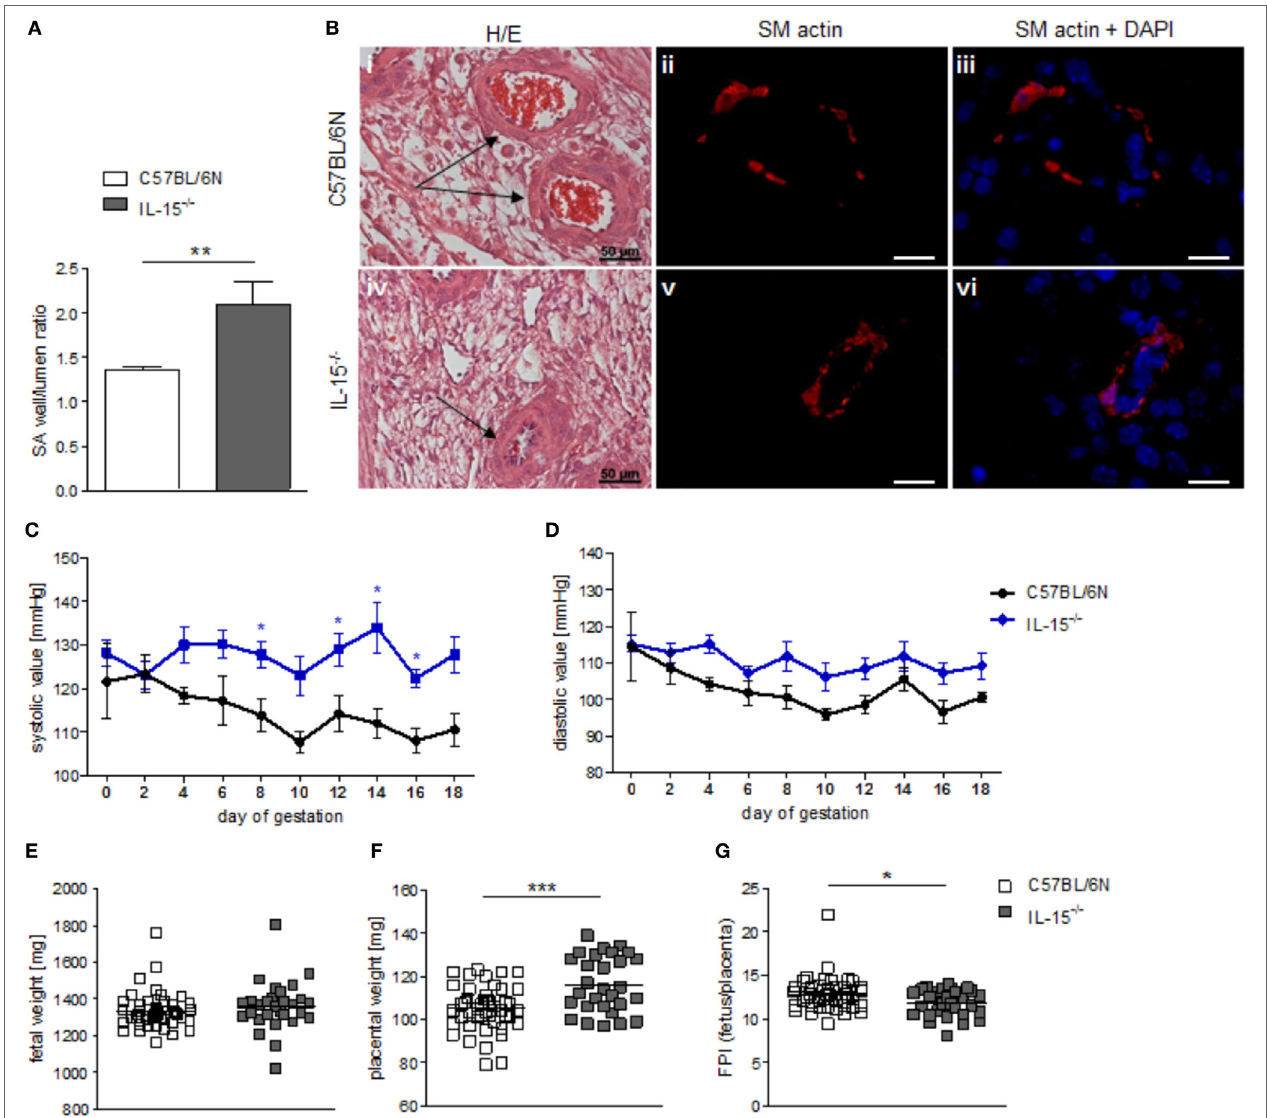
FigUre 3 | Interleukin (IL)-15 − / − mice showed impaired remodeling of spiral arteries (SAs), but no hypertension throughout pregnancy. While natural killer cell (NK) absence had no impact on fetal growth, it was associated with higher placental weight and lower fetoplacental-index (FPI). (a) SA wall and lumen perimeters of 3–10 SAs per animal of BL/6N ( n = 6) and IL-15 − / − ( n = 5) mice were measured and SA wall-to-lumen ratio were calculated. Results are presented as means with SEM. Statistical differences were obtained using Mann–Whitney U -test (** P < 0.01). (B) Representative images of H/E-stained sections (scale bar = 50 μ m) and immunofluorescence for smooth muscle (SM) actin and SM actin + DAPI (scale bar = 20 μ m) of SAs (indicated by arrows) of BL/6N and IL-15 − / − mice are shown. Systolic (c) and diastolic blood (D) pressure values for pregnant C57BL/6N ( n = 5) or IL-15 − / − ( n = 5) mice from gd0 to gd18. Data were recorded every second day. For (c,D) , results are presented as mean ± SEM. Statistical differences were obtained using Mann–Whitney U -test (* P < 0.05,). Fetal weights (e) , placental weights (F) , and FPI (g) from C57BL/6N (mothers: n = 5, fetus/placenta: n = 46) or IL-15 − / − (mothers: n = 5, fetus/placenta: n = 29) females at gd18. For (e–g) , results are presented with squares showing individual values for each fetus/placenta and means are indicated. Statistical differences were obtained using unpaired t -test (* P < 0.05, *** P < 0.001). IL, interleukin; SA, spiral arteries, NK, natural killer cells; FPI, fetoplacental-index; SM, smooth